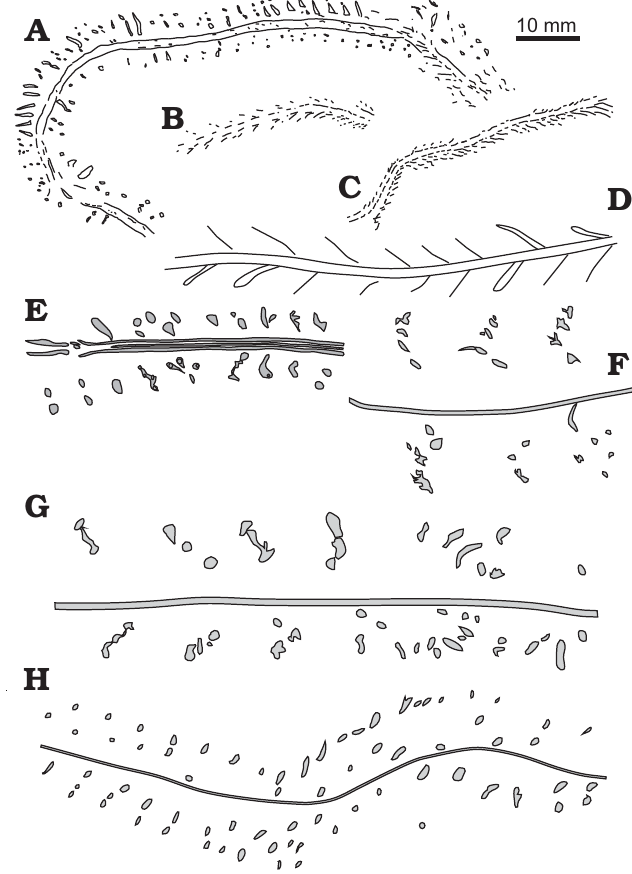
Fig. 8. Comparison of drawings of holotype Glaciichnium australis sp. nov. ( A ) to Glaciichnium liebegastensis ( B holotype, C ), trackway of a Recent caddisfly larvae Philopotamus montanus ( D ), lectotype of Siskemia elegans ( E ), Stiaria quadripedia ( F neotype, G ), and lectotype of Stiaria intermedia ( H ). B, C from Walter (1985: fig. 4A and B, respectively); E from Walker (1985: fig. 2a, part); F from Pollard and Walker (1984: pl. 2: 2); G from Walker (1985: fig. 5a); H from Walker (1985: fig. 5c).